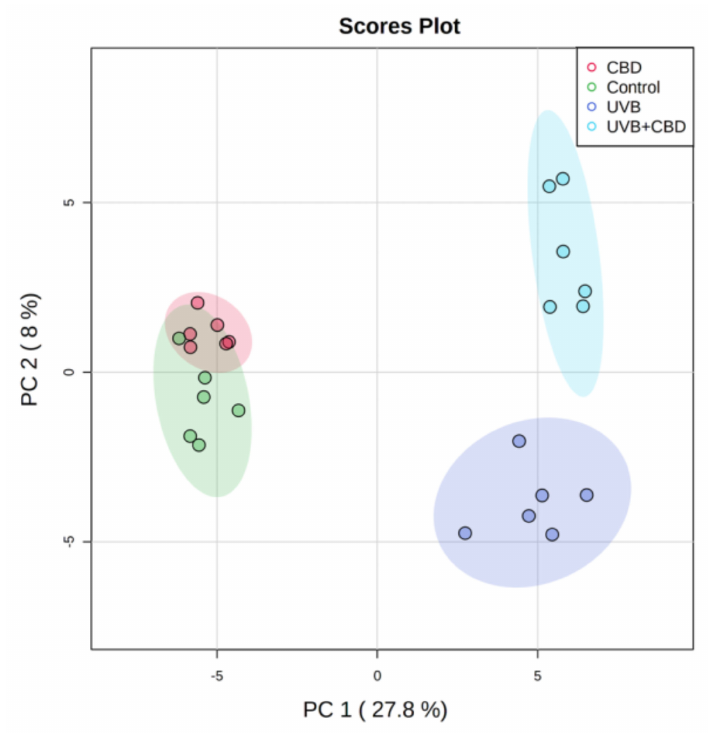
Figure 2. Two-dimensional principal component analysis (2D PCA) scores plots of the relative abundance of phospholipid species related to the internal standard of each phospholipid class in keratinocytes isolated from the skin of control (Control) and UVB-irradiated rats (increasing doses from 0.02 to 2 J / cm 2 for 4 weeks). These cells have not been treated (Control and UVA) or treated with CBD (CBD and UVA + CBD) (2.5 g CBD in 100 g